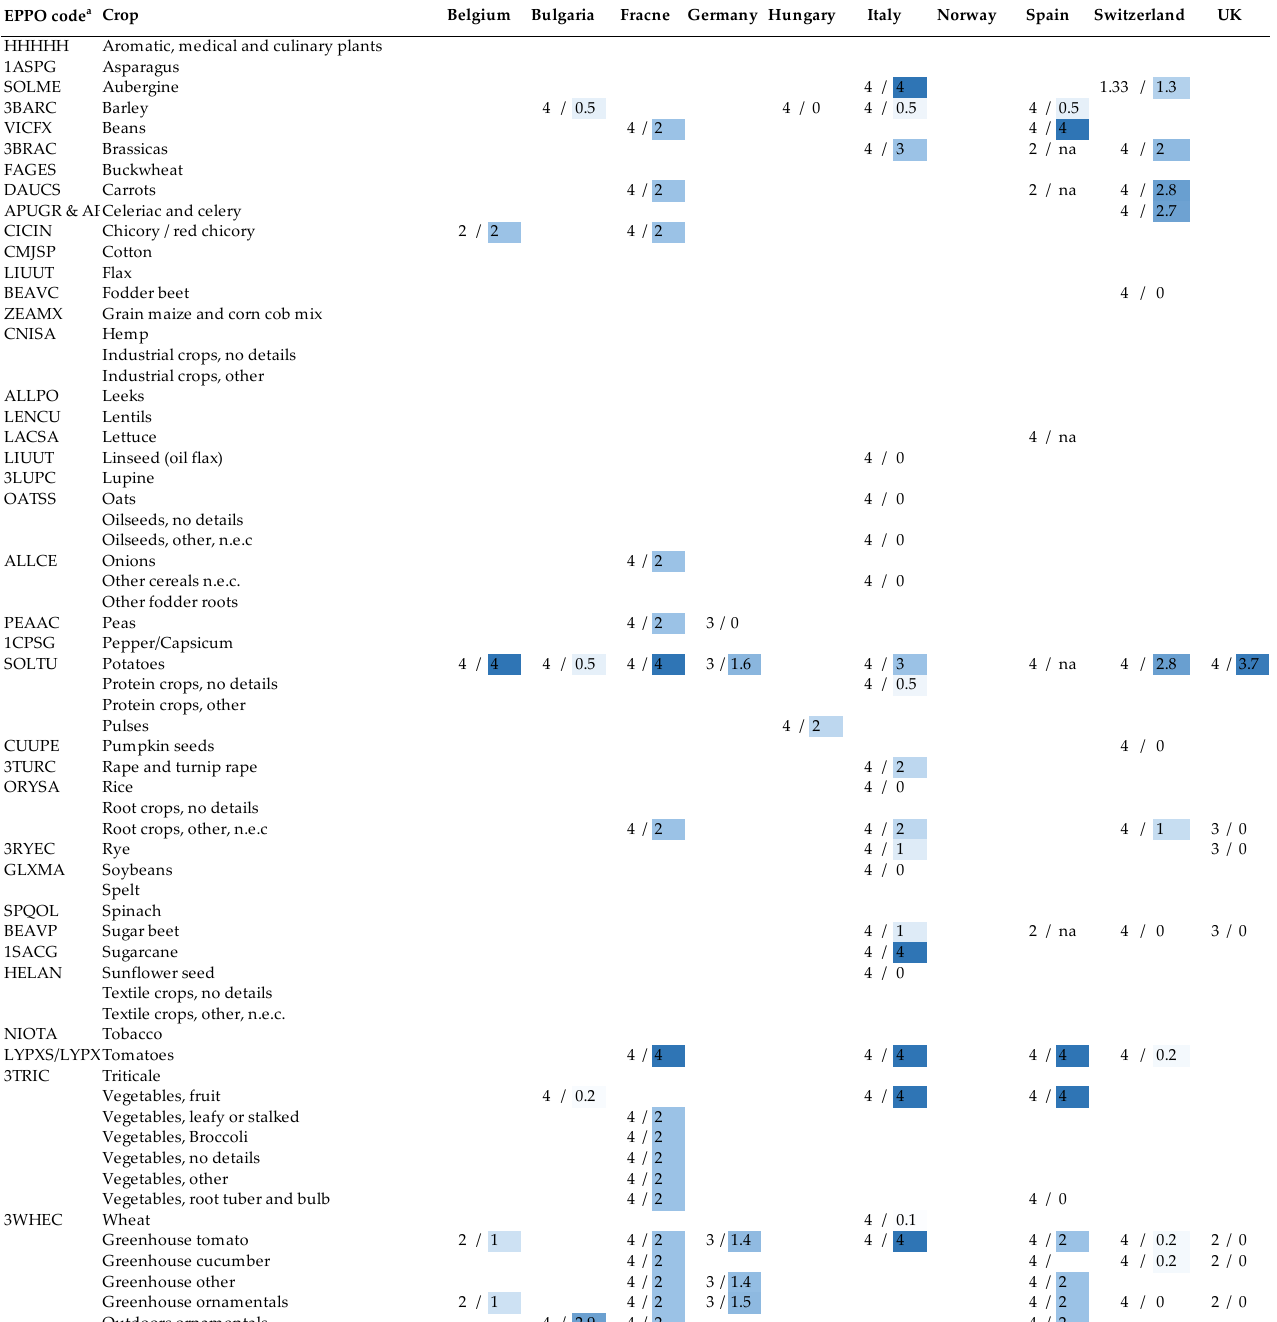
Figure 2. Copper-use authorizations and estimated real use (authorized use/ real use) in annual crops in kg per ha and year in organic farming in the 12 surveyed European countries. Colors visualize intensity of use (from no use (white) to a maximum of 4 kg (dark blue)). a EPPO codes according EPPO Global Database. https://gd.eppo.int (accessed on 7 March 2022). Organic farmers use between 0 and 100% of the maximum allowed amount of copper depending on the crop and/or country, i.e., copper utilization rates (copper used ) × (copper- allowed ) −1 ) ranged between 0 and 1. Over all surveyed countries, copper-utilization rates were <0.25 in 27% of the allowed cases (crops × country), <0.5 in 56%, and >0.75 in 27% of This survey in the 12 selected European countries covers 2.9 million hectares of the allowed cases (Table 3), with some variability between countries. The UK showed the organically managed horticultural (temperate fruits; grapes; olives; nuts; and vegetables, highest percentage of cases with utilization rates < 0.5 (94%), followed by Germany (70% including potato) and arable crops. Permanent grasslands were not included. The